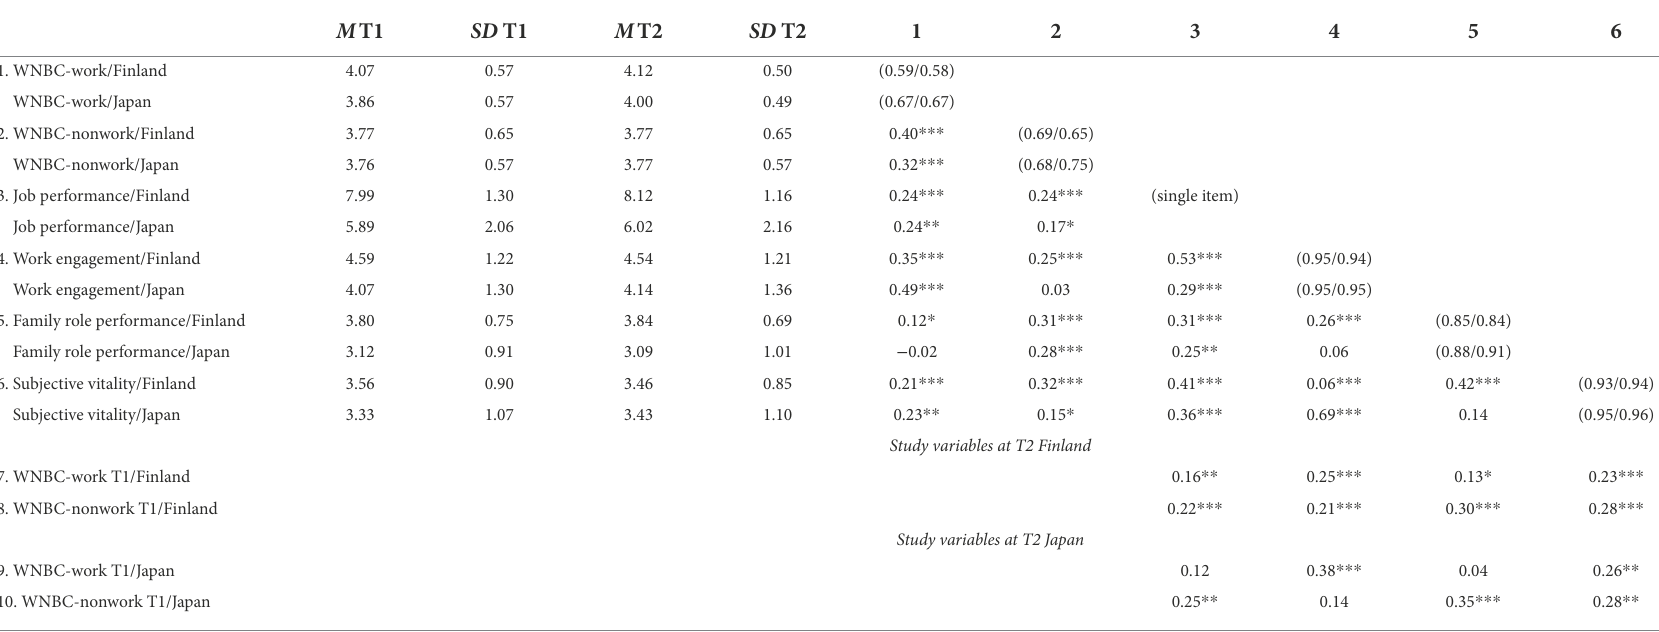
TABLE 6 Partial correlations and McDonald’s ω between brackets on the diagonal (T1/T2) among the WNBC dimensions, job performance, work engagement, family performance and subjective vitality (controlled for gender, age, education level and vocational position) in the sample from Finland and